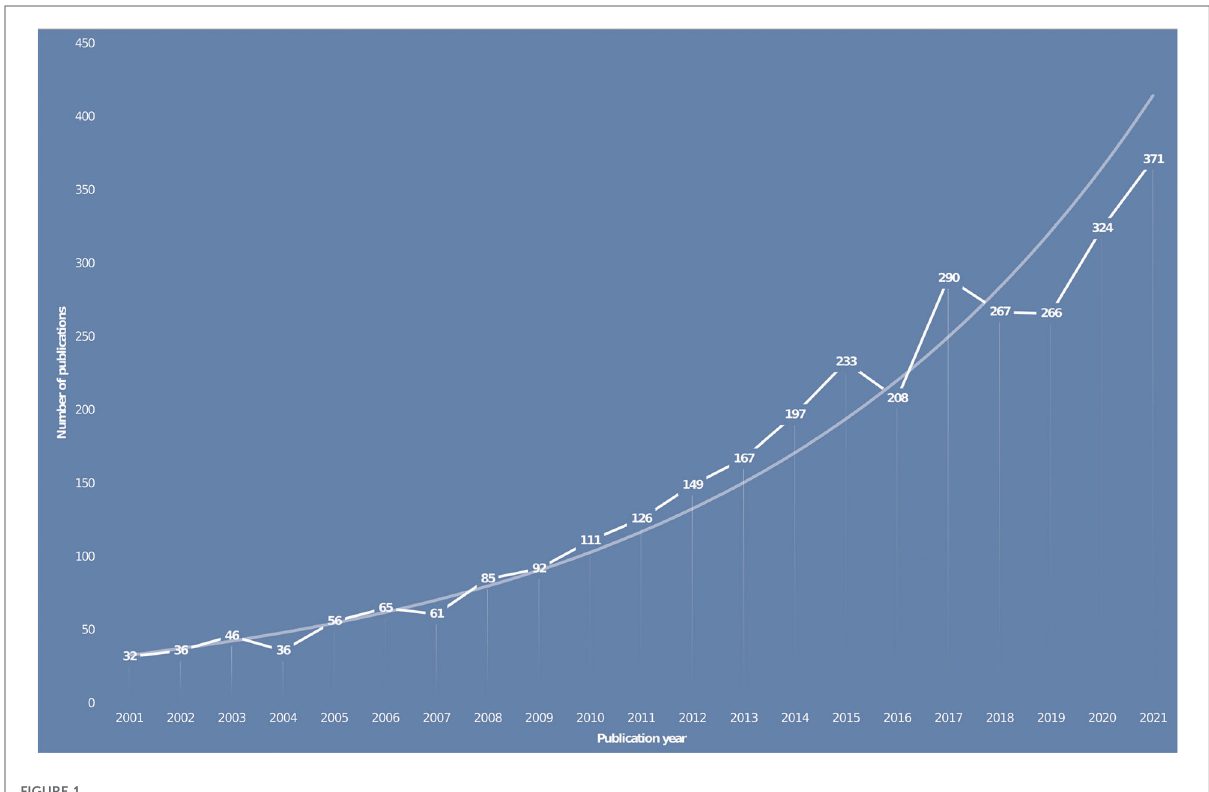
FIGURE 1 Annual research publications involving KOA and the meniscus from 2001 to 2021. KOA, knee osteoarthritis.